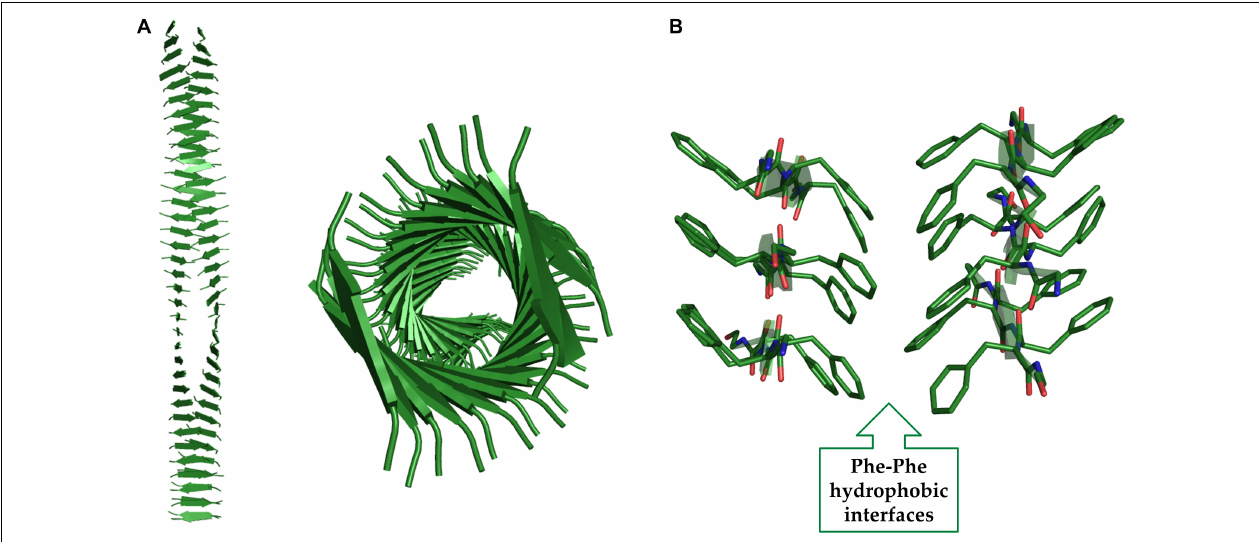
FIGURE 8 | Two different views of the F 6 structure obtained from MD studies (A) . The interactions at the hydrophobic interfaces are shown (B) .